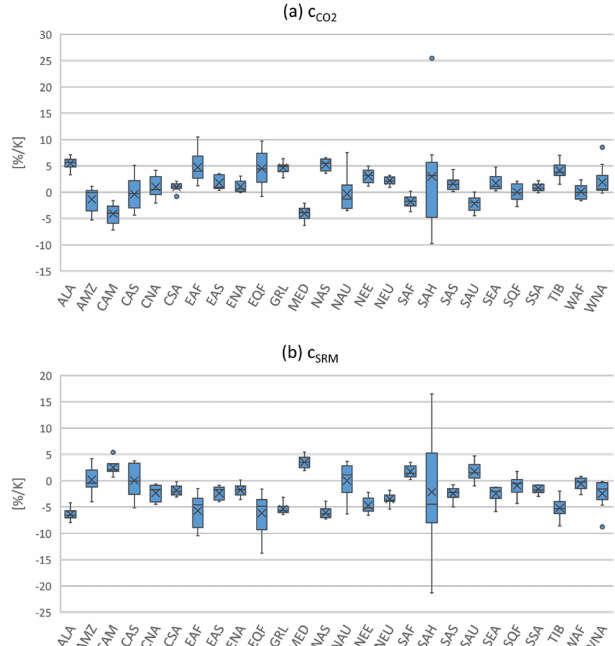
Figure A1. Variation of scaling coefficients for regions from nine AOGCMs. The boxes are drawn from the first quartiles to the third quartiles. The horizontal lines go through the boxes at the medians. The crosses show the averages. The whiskers go from each quartile to the minimums or maximums. The dots represent the